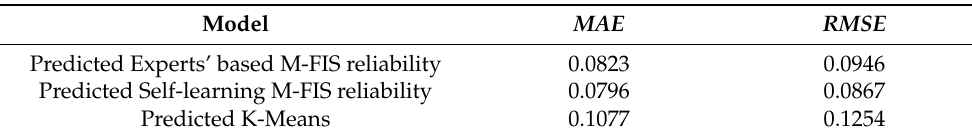
Table 3. Model error results.